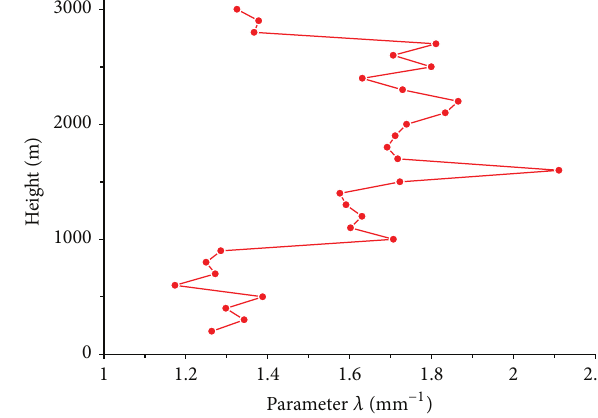
Figure 8: Time-height cross section of rain rates recorded by the MRR in 8 minutes of precipitation.